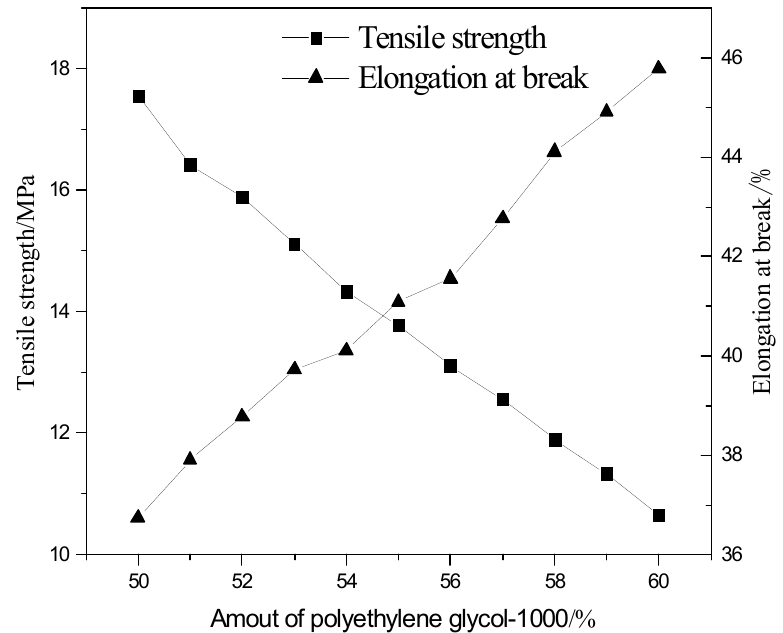
Figure 9. Effect of polyethylene glycol-1000 the amount of tensile strength and elongation at break. Table 3. Effect of amount of polyethylene glycol-1000 on the hardness and adhesion. Amount of Polyethylene Elongation at Break Tensile Strength Glycol-1000 the/%